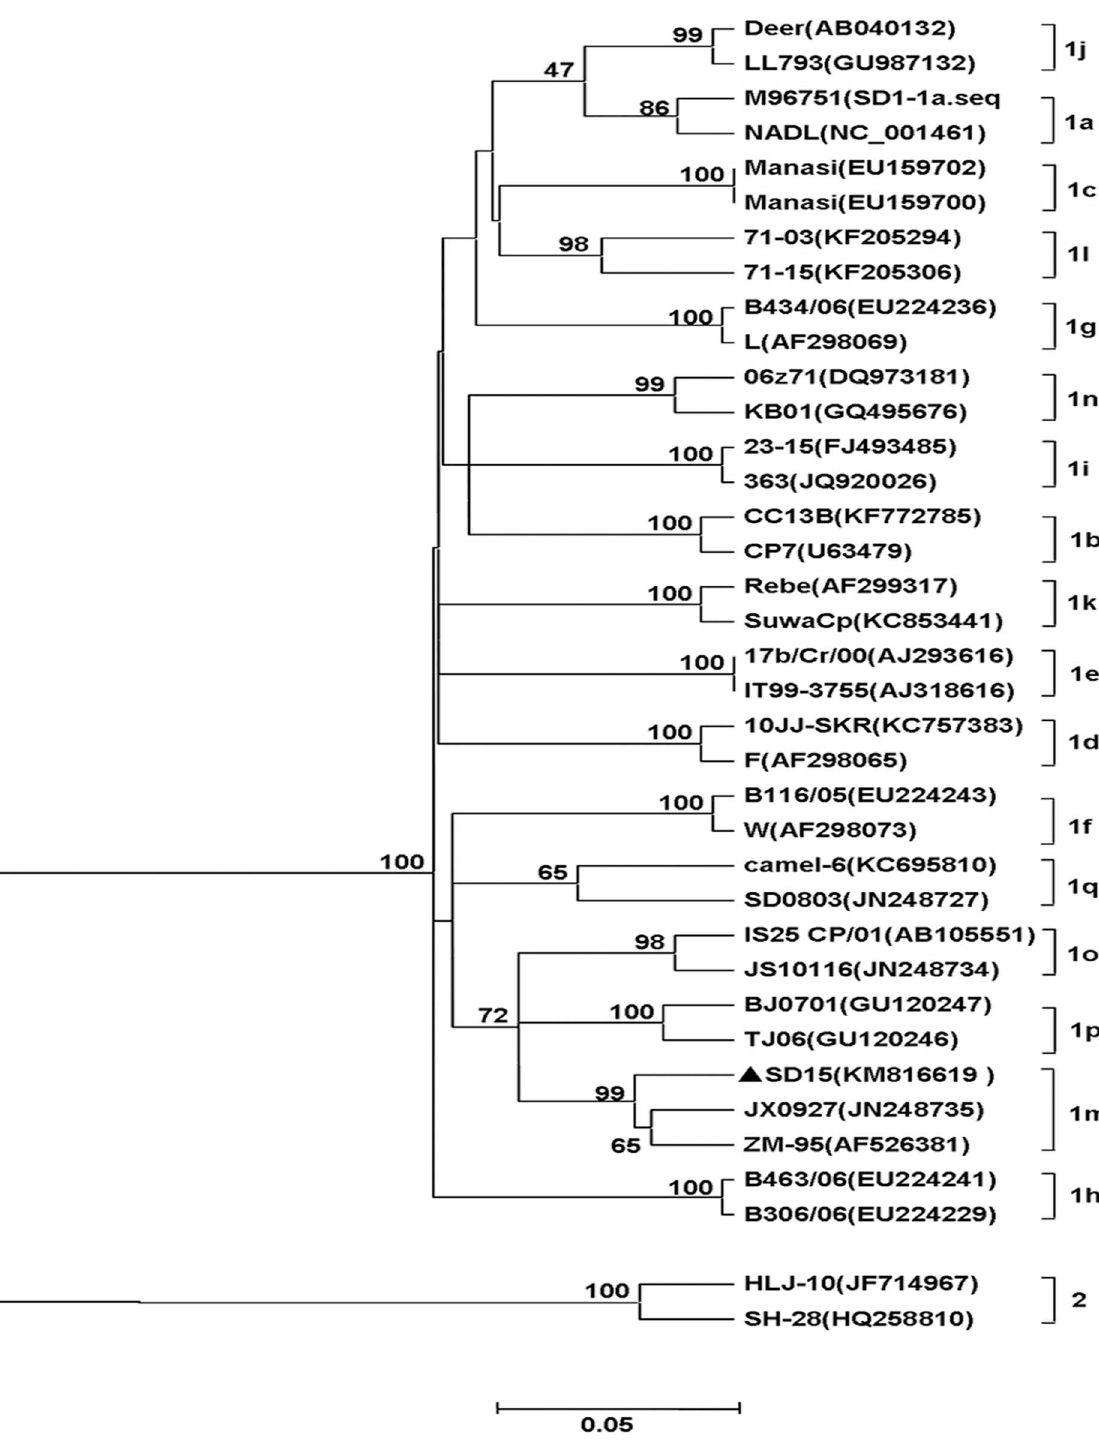
PLOS ONE | DOI:10.1371/journal.pone.0165044 October 20,